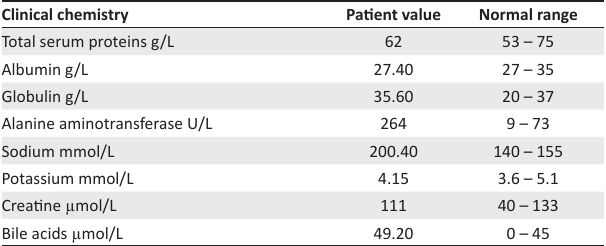
TABLE 3: Biochemical results.